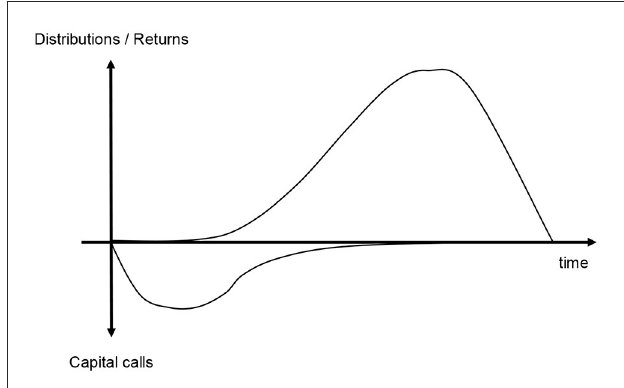
FIGURE2 Expected cashflows projected by Takahashi-Alexander